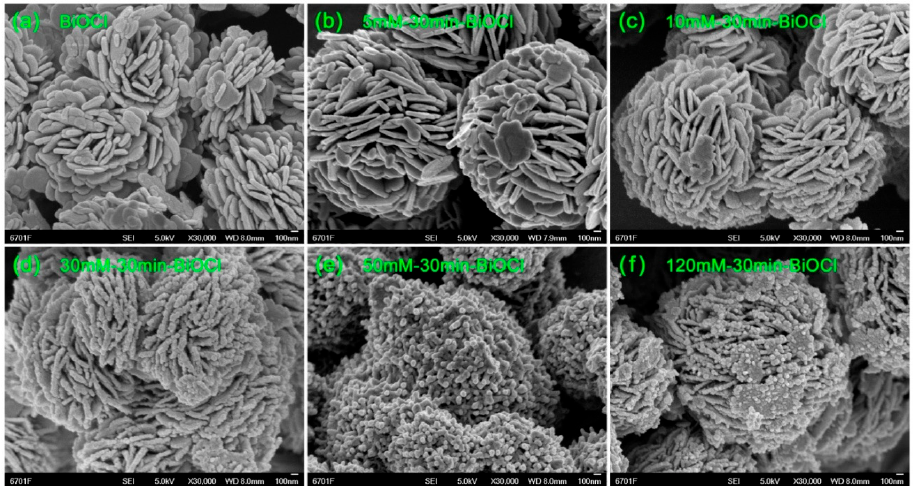
Figure 3. SEM images of pristine and NaBH 4 -treated BiOCl samples with different concentrations.